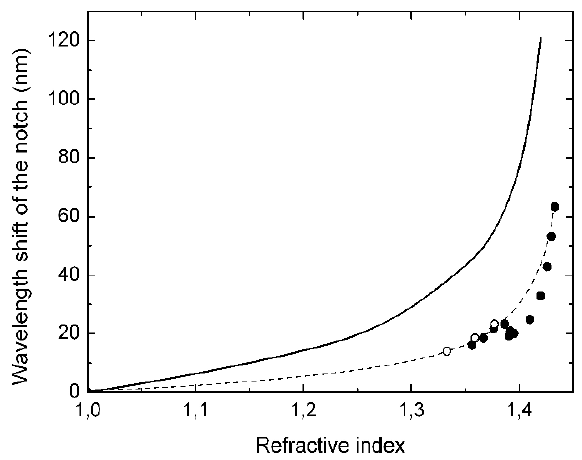
Figure 5. Wavelength shift of a resonant coupling versus external refractive index: (solid line) theoretical shift of the resonance, (solid circles) experimental values obtained with Cargille liquids, (open circles) experimental values obtained with standard liquids (see Figure 4), (dashed line) eye